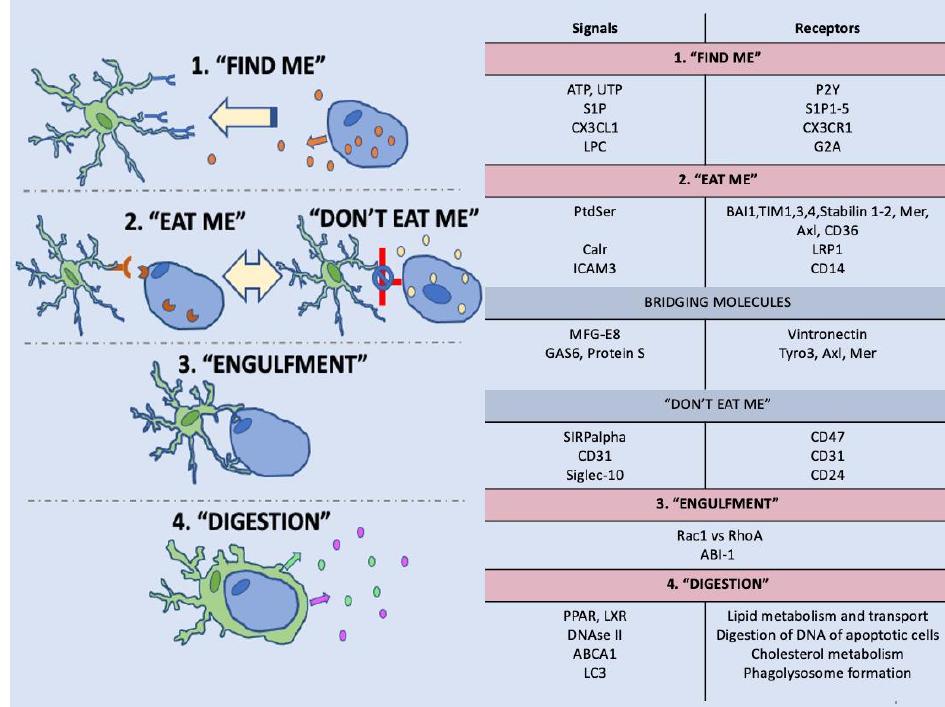
Figure 1. Four steps of efferocytosis: “Find me”, eat me”, “engulfment”, and “digestion” phase represent four main steps of efferocytosis characterized by a high level of complexity of their regulation that involves multiple signaling molecules, receptors, and pathways [30,34,43,45,48,52–62]. The engulfment of AC can promote the anti-inflammatory response of the efferocyte [63]. P2Y- purinergic P2Y receptor, S1P1-5- sphingosine 1-phosphate receptor subtype 1-5, CX3CR1- C-X3-C Motif Chemokine Receptor 1, G2A- G protein coupled receptor Gpr132, TIM- T cell immunoglobulin mucin receptor, Tyro3, Axl, Mer- TAM receptor tyrosine kinases, LRP1- LDL receptor related protein 1, ABI-1- Abl interactor 1, LC3- microtubule associated protein 1A/1B light chain 3, SIRPalpha- signal-regulatory protein-alpha, Siglec-10- sialic acid binding Ig-like lectin 10. One of the best described “eat me” signals is phosphatidylserine, which is normally confined to the inner cytoplasmic leaflet of the plasma membrane by a “flippase”. Apoptosis activates a “scramblase” that quickly exposes phosphatidylserine on the cell surface [64] and stimulates a wide range of immunological responses, including the activation of anti- inflammatory and immunosuppressive pathways that prevent both local and systemic immune activation [65]. Other groups of signals capable of triggering efferocytosis in parallel with chemotactic signals are electrostatic signals resulting from damage of the cellular membrane [66]. In a model of endothelial efferocytosis, the endothelial AC were strongly negatively charged and attracted positively charged endothelial cells triggering reorganization of their cytoskeleton and sprouting [66]. The most abundant negatively charged structure in eukaryotic membranes is phosphatidylserine [65]. Phosphatidylserine is a glycerophospholipid with the ability to direct proteins with a positive charge [65,67]. The function of externalized phosphatidylserine as an “eat me” signal is complex